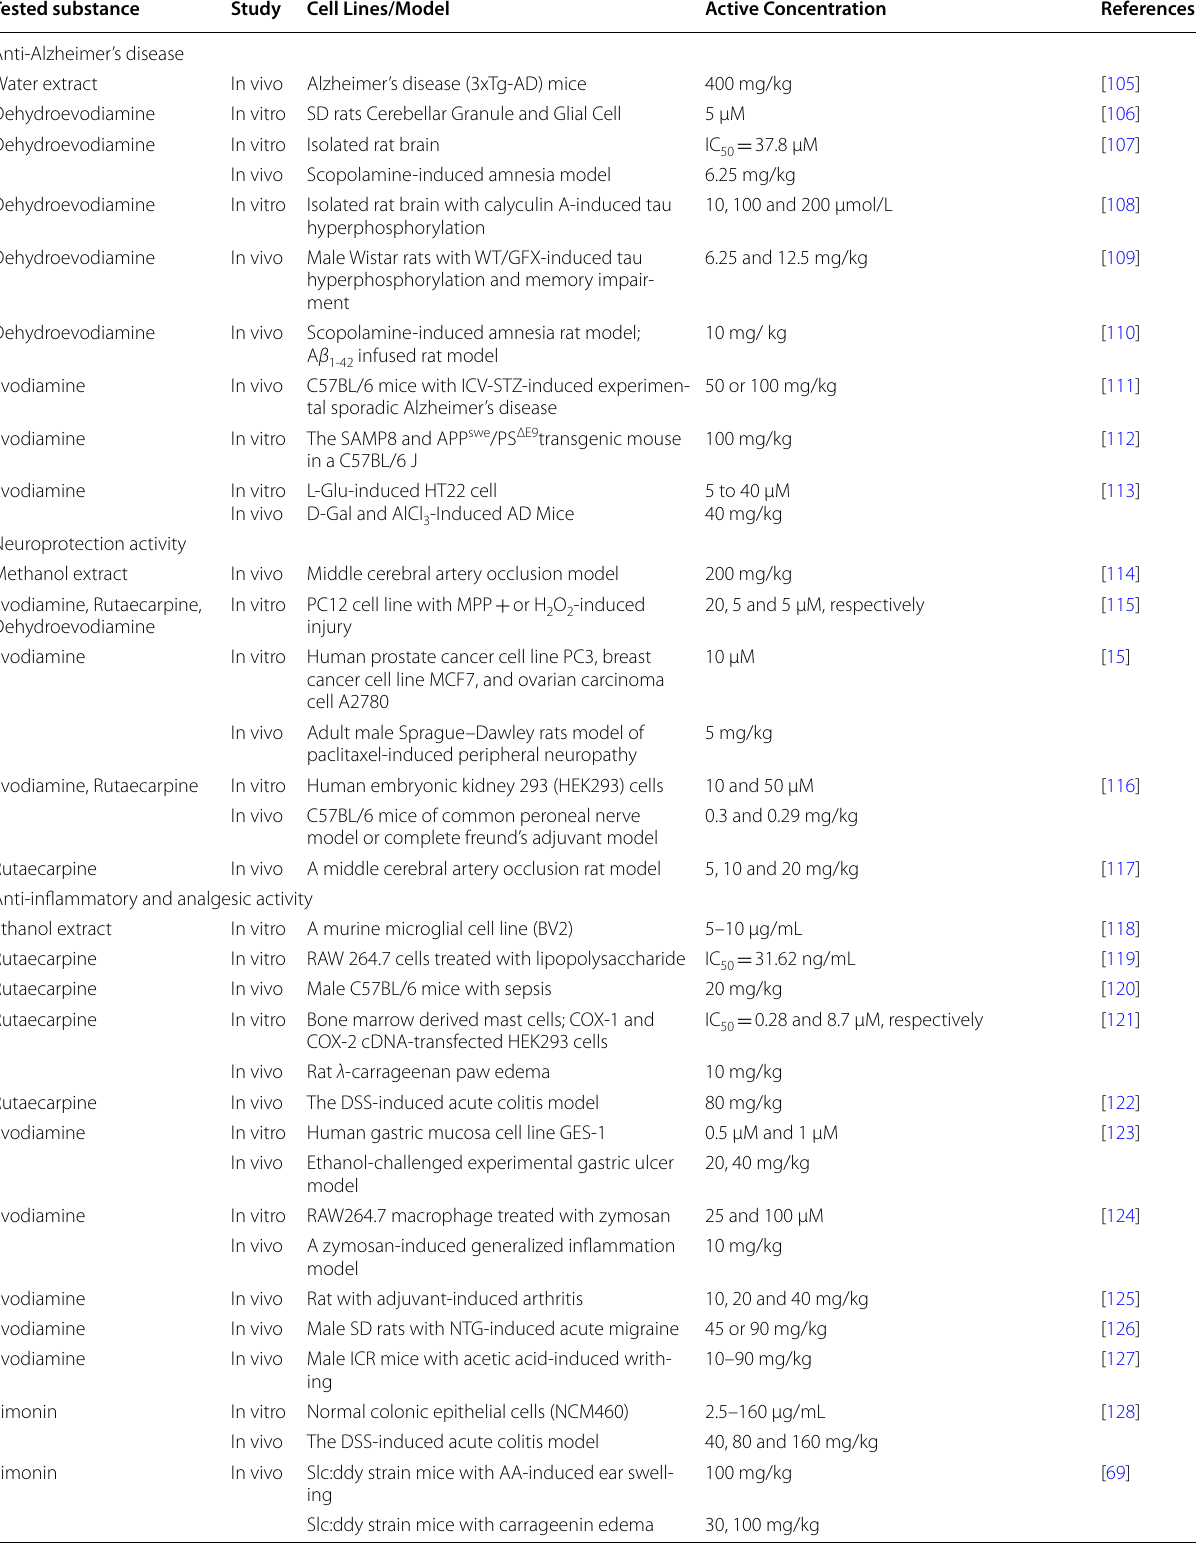
Table 4 Pharmacological activities of Euodiae Fructus Tested